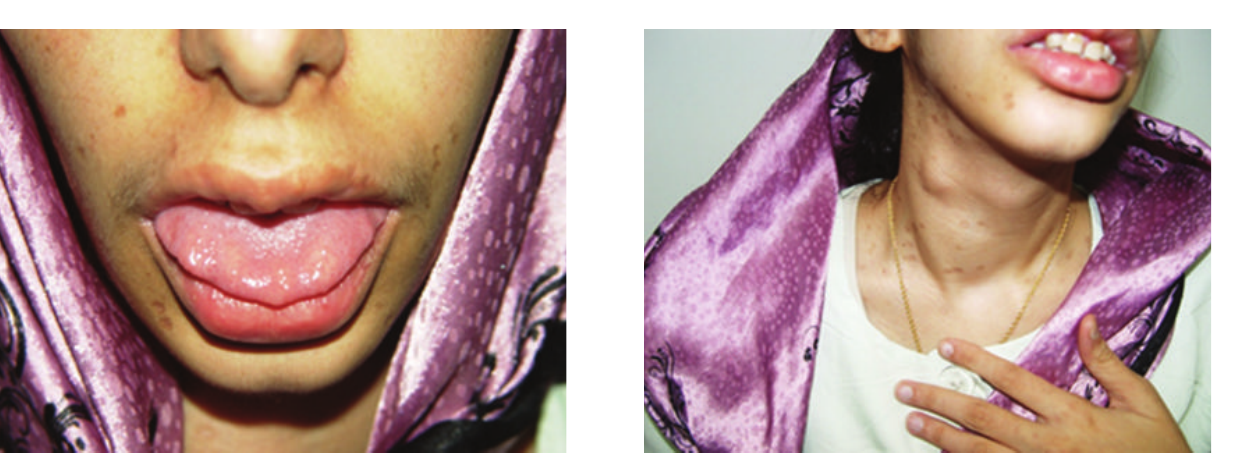
Figure 1: The patient had mucosal neuromas on the anterior third of her tongue. Note the bumpy/blubbery lips.